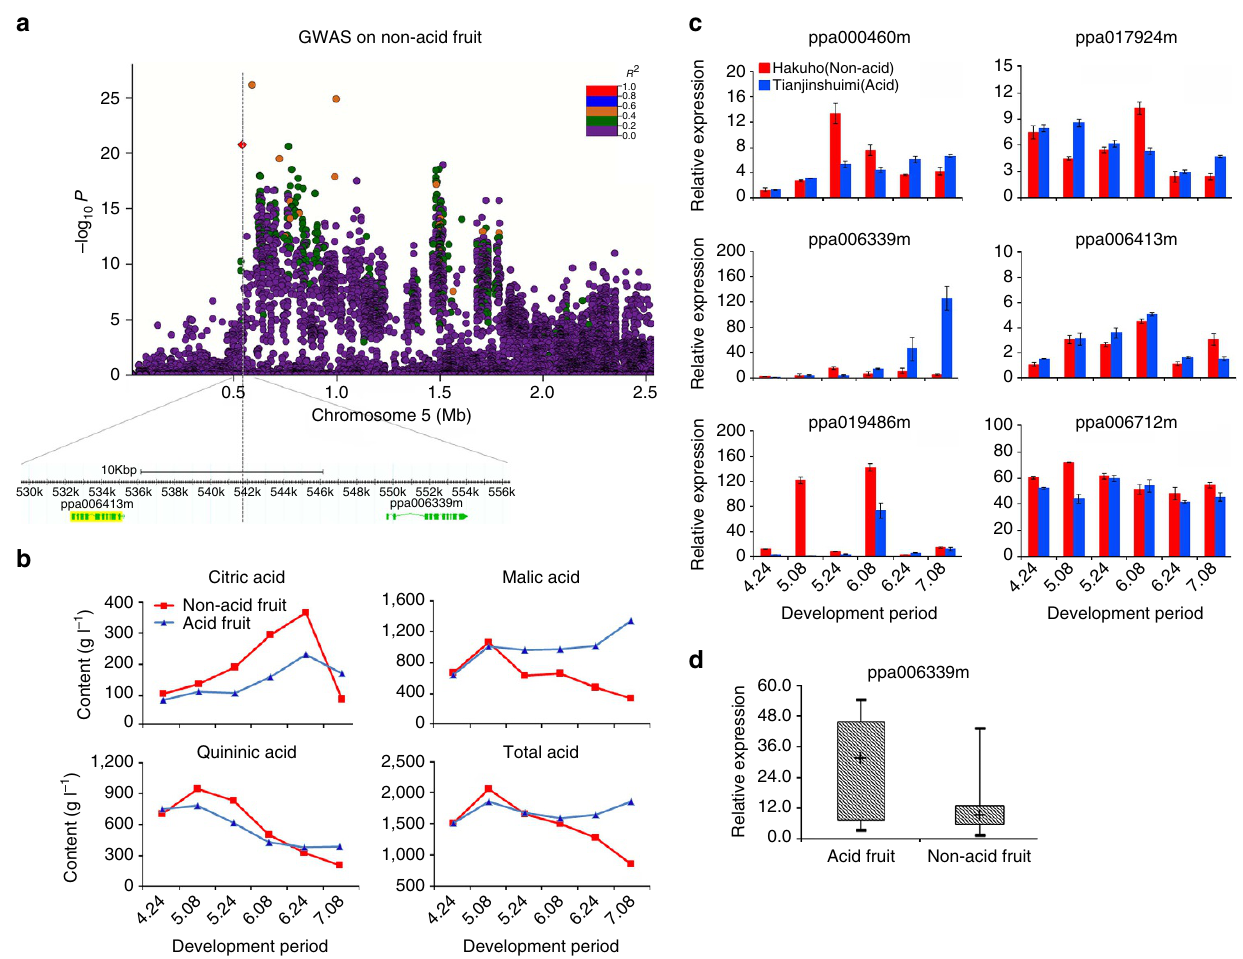
Figure 2 | Association results for the non-acid fruit trait and expression profiles of candidate genes in peach. ( a ) Location of the locus associated with the non-acid fruit trait identified on scaffold_5 using the GLM-PCA model. Legends and colour codes for r 2 are the same as described in Fig. 1. ( b ) Variation in citric acid, malic acid, quininic acid and total acid contents during the development of acid and non-acid peach accessions. ( c ) Relative expression of the six genes associated with acid and non-acid peach accessions (indicated in different colours), as quantified by qRT–PCR. ( d ) Relative expression of the candidate gene ppa006339m in the mature fruits of nine acid and 15 non-acid accessions. Values represent mean ± s.d. of triplicates for qRT–PCR in each